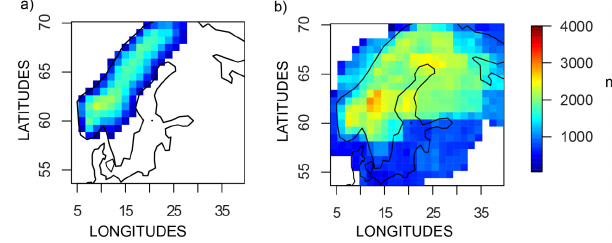
Figure 1. Fennoscandian ice sheet extent and elevation (m) (a) as in the RCA3 MIS 3 stadial simulation by Kjellström et al. (2010) and (b) as extracted from the ICE-5G data by Peltier (2004) for the RCA3 LGM simulation by Strandberg et al. (2011) . Data have been bilinearly interpolated to a 1.5 ◦ × 0.75 ◦